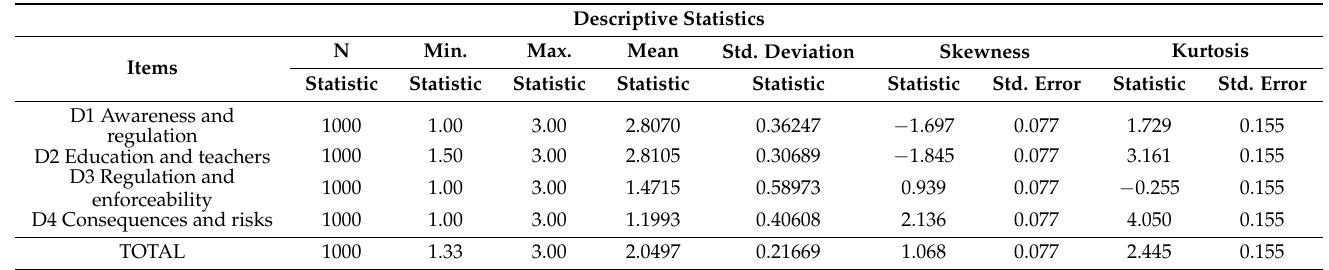
Table 8. Descriptive statistics for questionnaire dimensions.